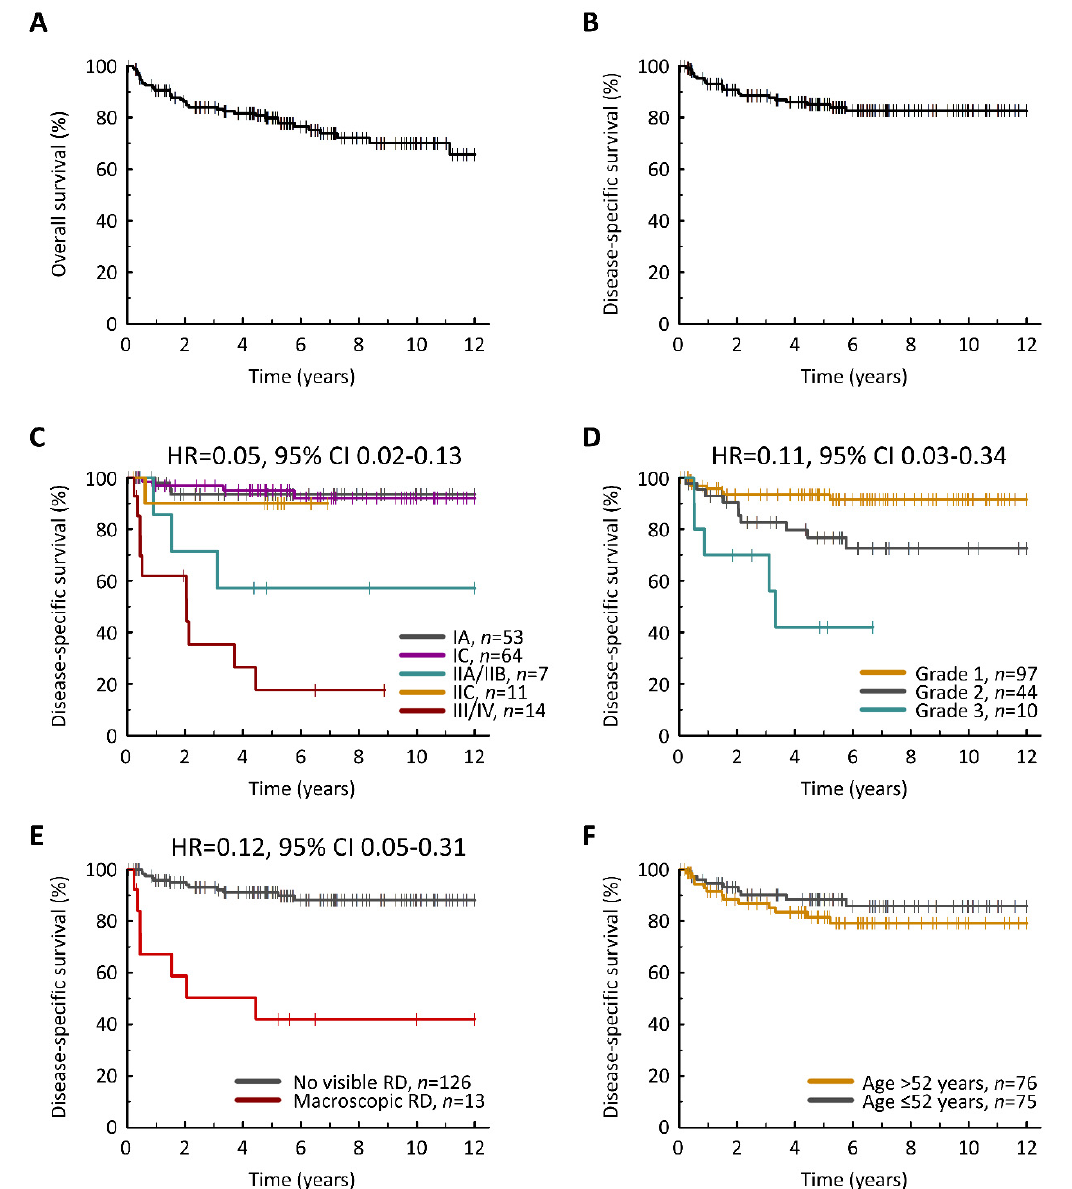
Figure 2. Clinical outcome in mucinous ovarian carcinoma. ( A ) Overall survival. ( B ) Disease-specific survival (DSS). ( C ) DSS according to FIGO stage at diagnosis; labelled hazard ratio (HR) represent comparison of stage I vs. III/IV. ( D ) DSS according to disease grade; labelled HR represents comparison of grade 1 vs. grade 3 cases. ( E ) DSS according to residual disease (RD) status following surgical debulking. ( F ) DSS according to age at diagnosis. HR for age as a continuous variable = 1.03 (95% CI 1.00–1.06).